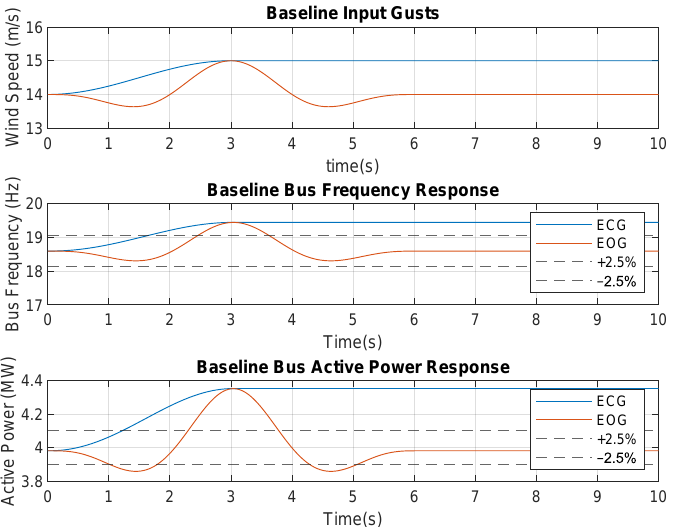
Figure 8. Baseline system test for both ECG and EOG. ∆ T = 3 s V gust max = 15 m/s.